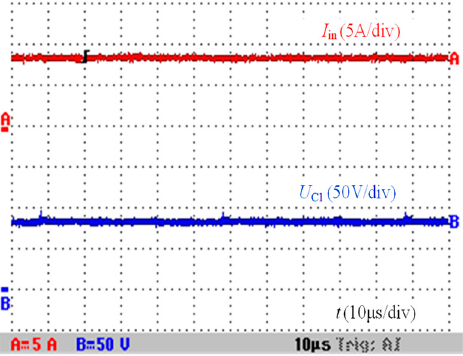
Figure 8. The current flowing into the inductor L a and the voltage across the capacitor C 1 .